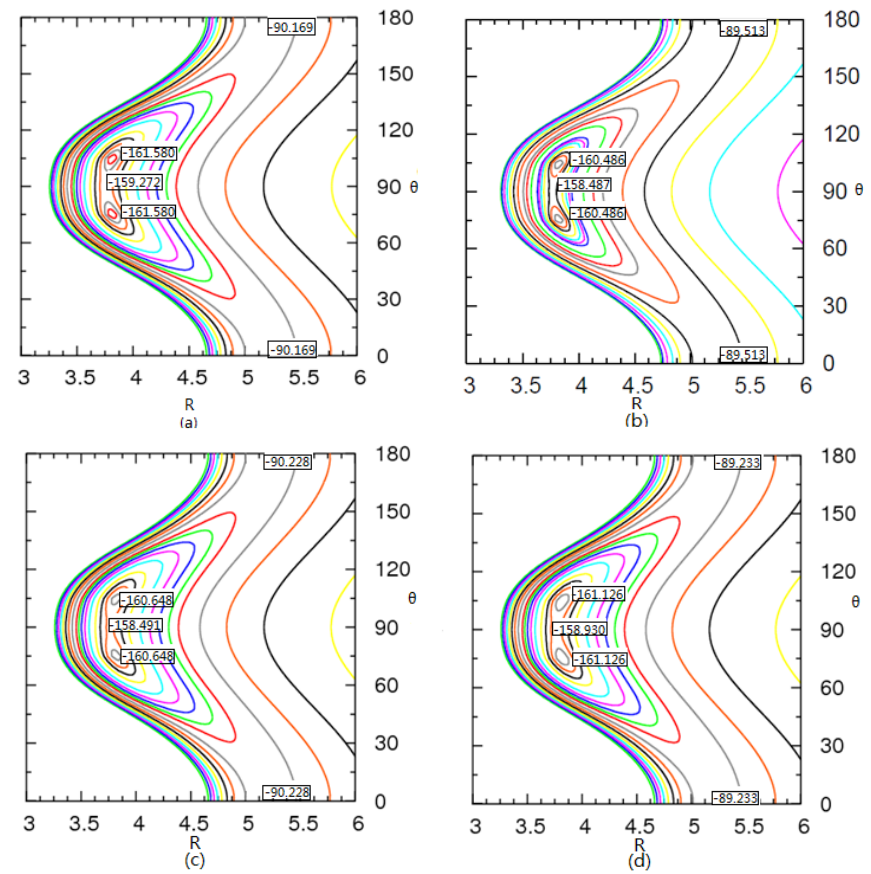
Figure 2: Contour plots of PES, R(Å) in angstrom and ɵ in degree. (a) basis set I, (b) basis set II, (c) basis set III, (d) basis set IV. Table 2: The calculated geometries and their corresponding energies on the PESs with different basis sets (R in angstrom, angle in degree, and energy in cm -1